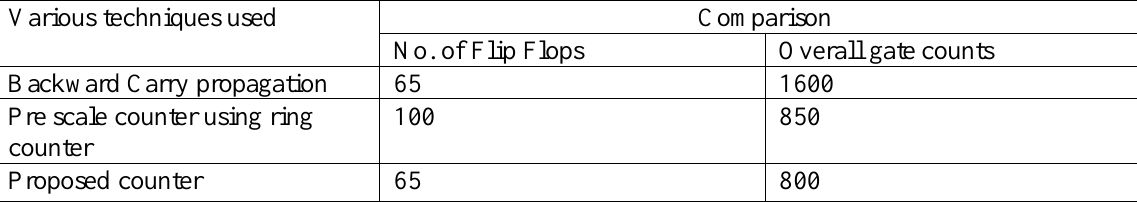
Table 2. Defines the performance comparison of various techniques used for low number of